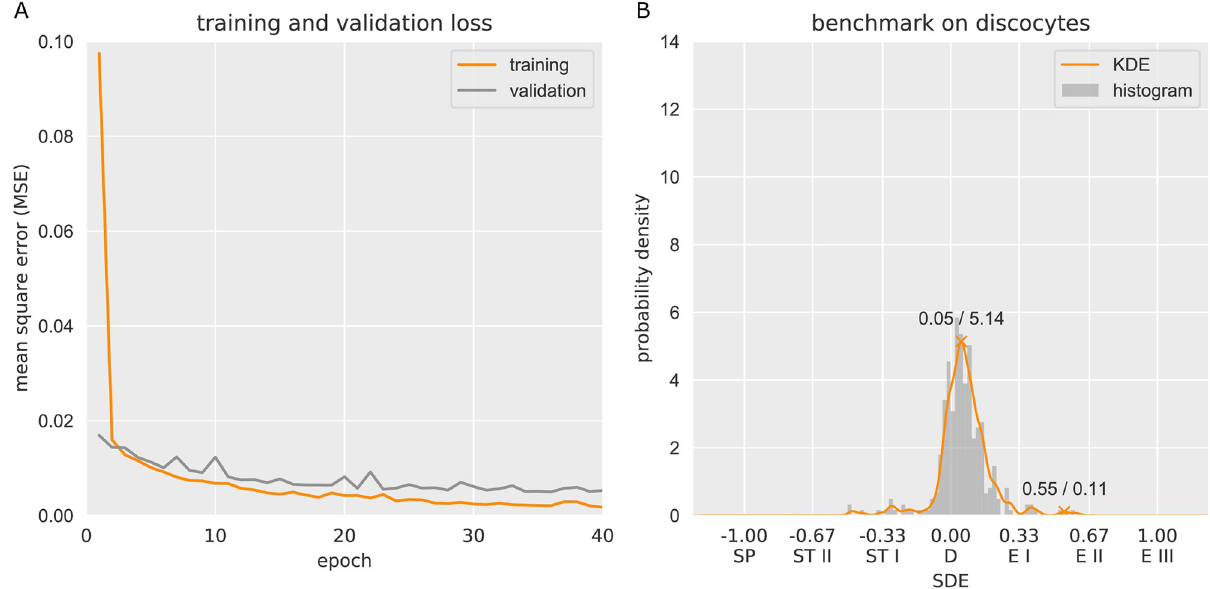
Fig 3. Training and validation loss for the second-stage ANN. (A) Within 40 epochs, the mean squared error (MSE) of the system was minimized. (B) Test on a representative set of 308 independent discocytes. The head of the distribution is allocated at 0.05, and the vast majority of cells is located within the range of − 0.15 to